Question: In a single sentence, describe what this figure presents.
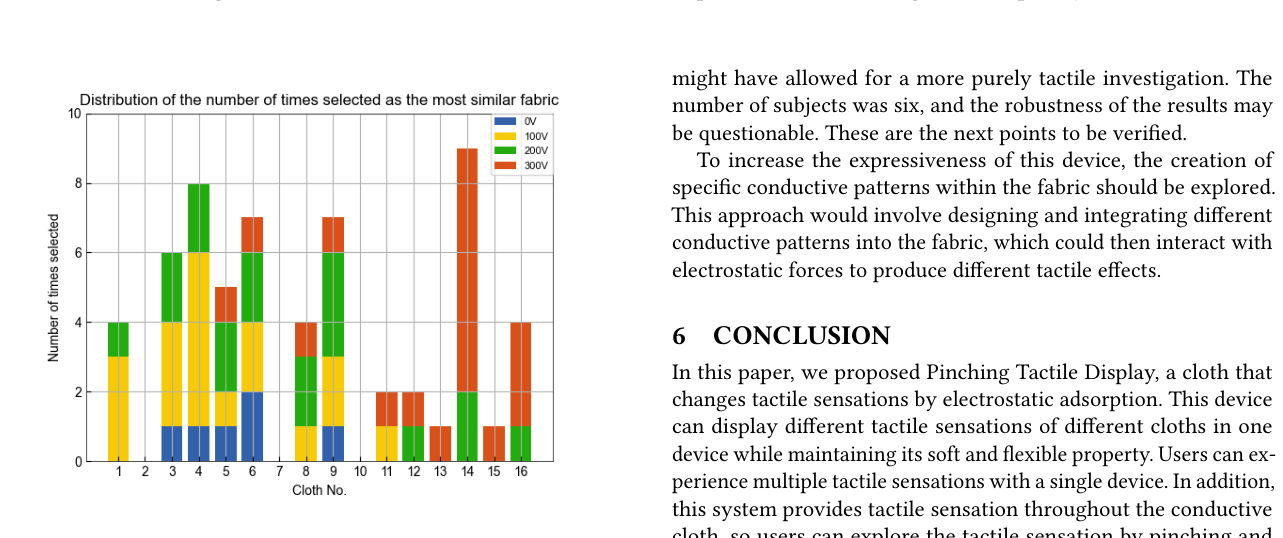
Answer: Distribution of the number of times selected as the most similar fabric.